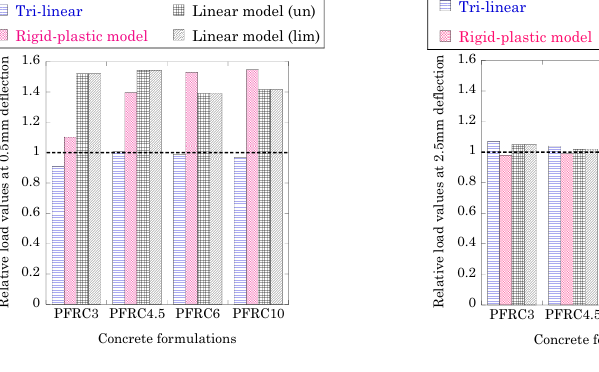
Figure 9. Comparison of the loads borne by the simulations at certain deflection values with respect to the experimental values.